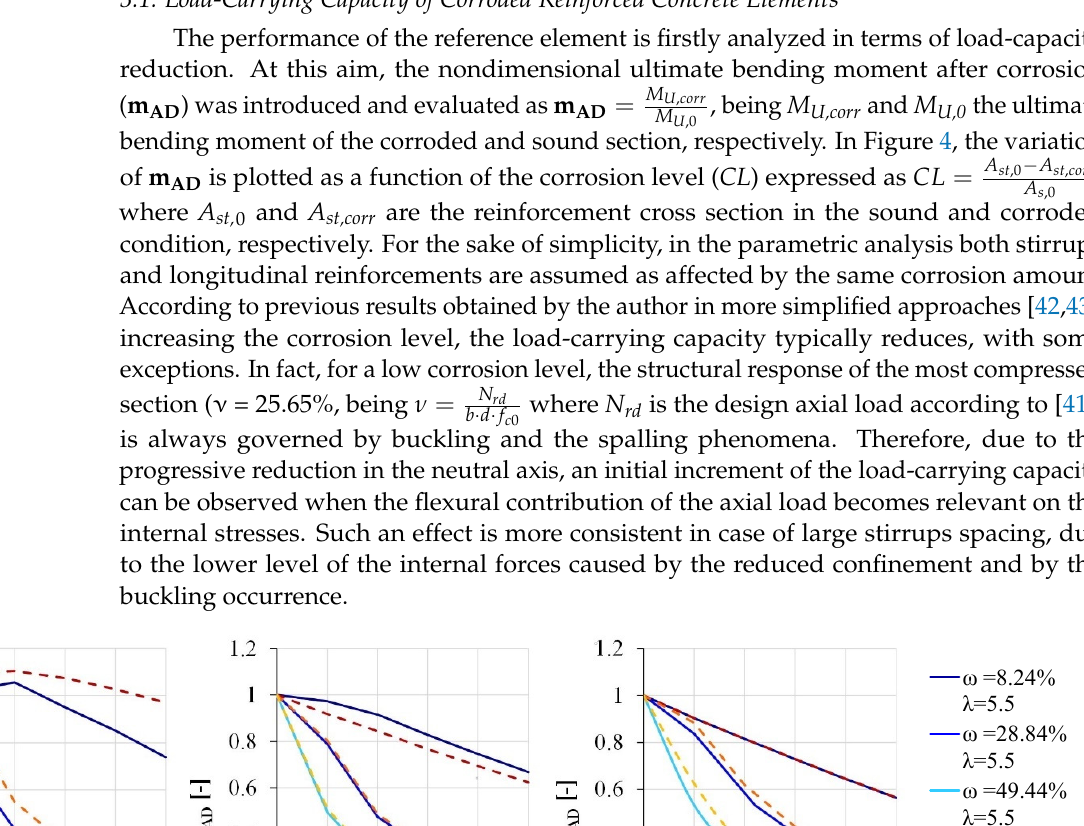
( b ) Figure 5. Load ‐ carrying capacity variation due to the corrosion degradation: comparison between the simplified model disregarding the buckling effects and the reference section. ( a ) ν = 25.65%, ( b ) ν = 15.39%. Finally, the classical simplified models are considered, disregarding the concrete cover and eventually the influence of the lateral instability of the longitudinal reinforce ‐ ment (Figure 6). In detail, disregarding only the concrete cover, a significant overestima ‐ tion of the effective load ‐ carrying capacity can be attained by adopting the simplified models, that progressively reduces increasing the superimposed axial load. Instead, the error of the simplified approach become reasonable if both the instability of the com ‐ pressed reinforcement and the contribution of the concrete cover are disregarded: an un ‐ derestimation of the real response can be observed that amount to about the 10% if the superimposed axial load is 30% of the maximum sectional capacity in compression.